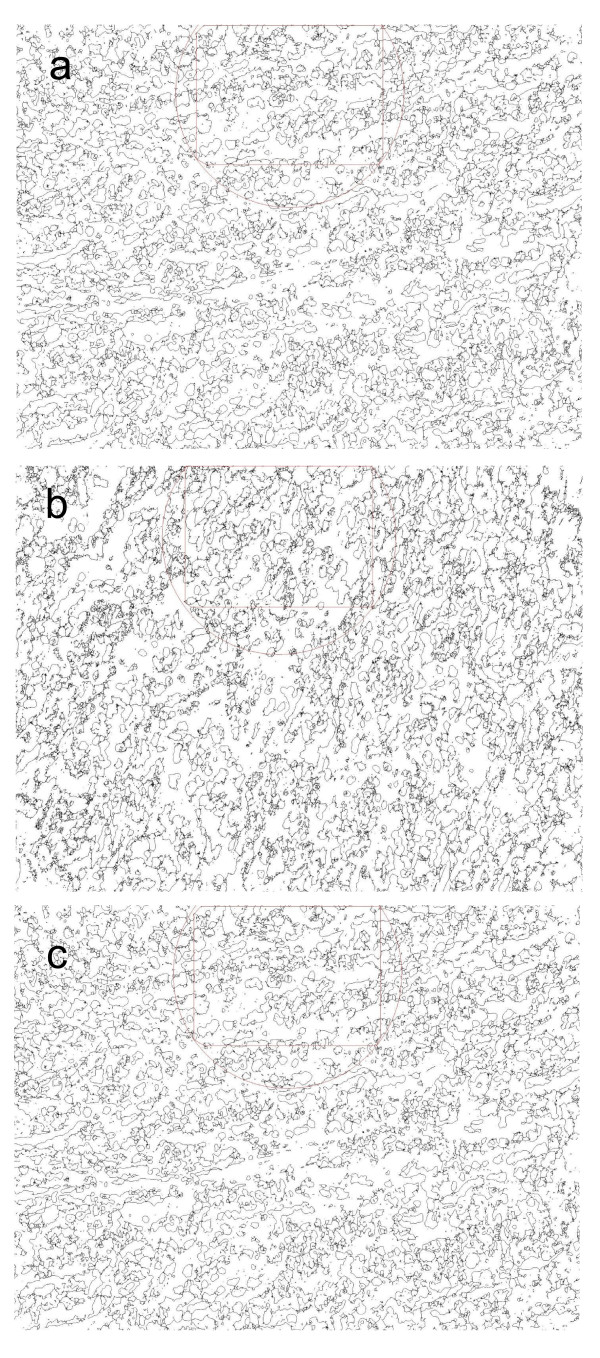
Morphometric analysis of placental vascular network of late pregnant ewes supplemented with alpha tocopherol, gamma tocopherol or placebo. a. Morphometric parameter of placental network of ewe supplemented with γ tocopherol. Field demarked as red-square had Fractal dimension 1.6204 and lacunarity 0.4967. A total of 30 fields were evaluated for each sample; b. Morphometric parameter of placental network of ewe supplemented with α tocopherol. Field demarked as red-square had Fractal dimension 1.7030 and lacunarity 0.5884. A total of 30 fields were evaluated for each sample. c. Morphometric parameter of placental network of ewe treated with placebo. Field demarked as red-square had Fractal dimension 1.6263 and lacunarity 0.6033. A total of 30 locations were evaluated for each sample.